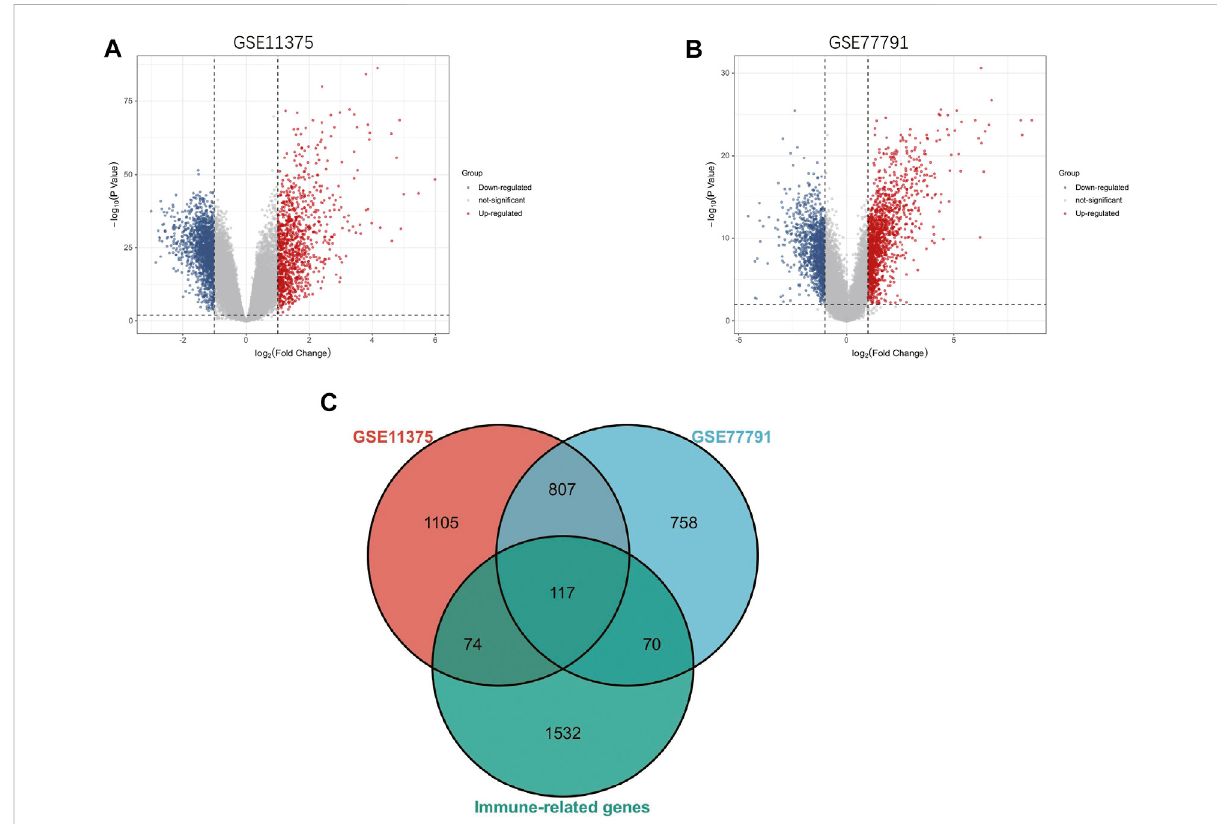
FIGURE 2 (A) The volcano map of GSE11375. (B) The volcano map of GSE77791. (C) Venn diagram show that 117 overlapping immune-related DEGs in GSE11375, GSE77791 and ImmuCellAI